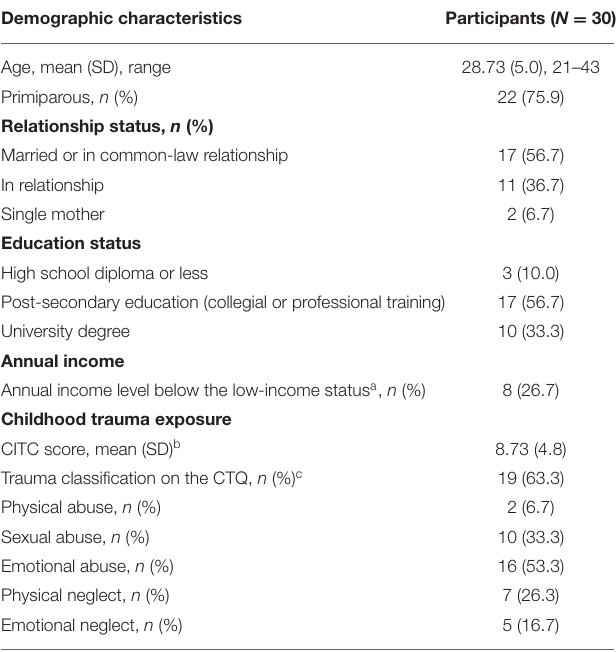
TABLE 1 | Demographics of pregnant women who participated in the STEP program ( N = 30). Demographic